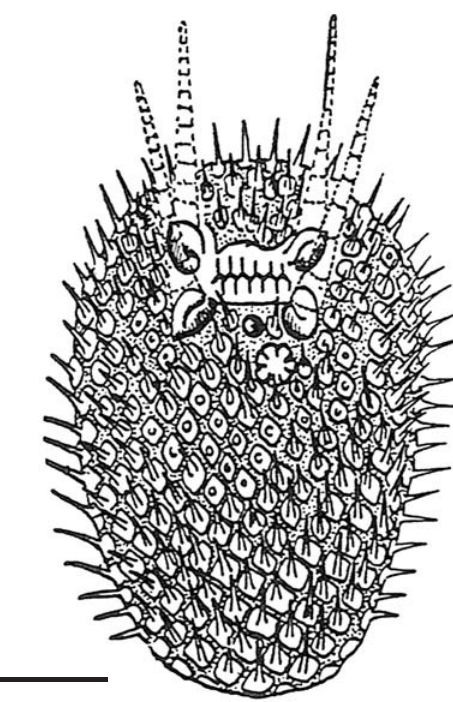
Fig. 3. Original reconstruction of the diploporite blastozoan Lepidocalix pulcher Termier and Termier, 1950a (see Termier and Termier 1959; Kes- ling 1968). Scale bar 10